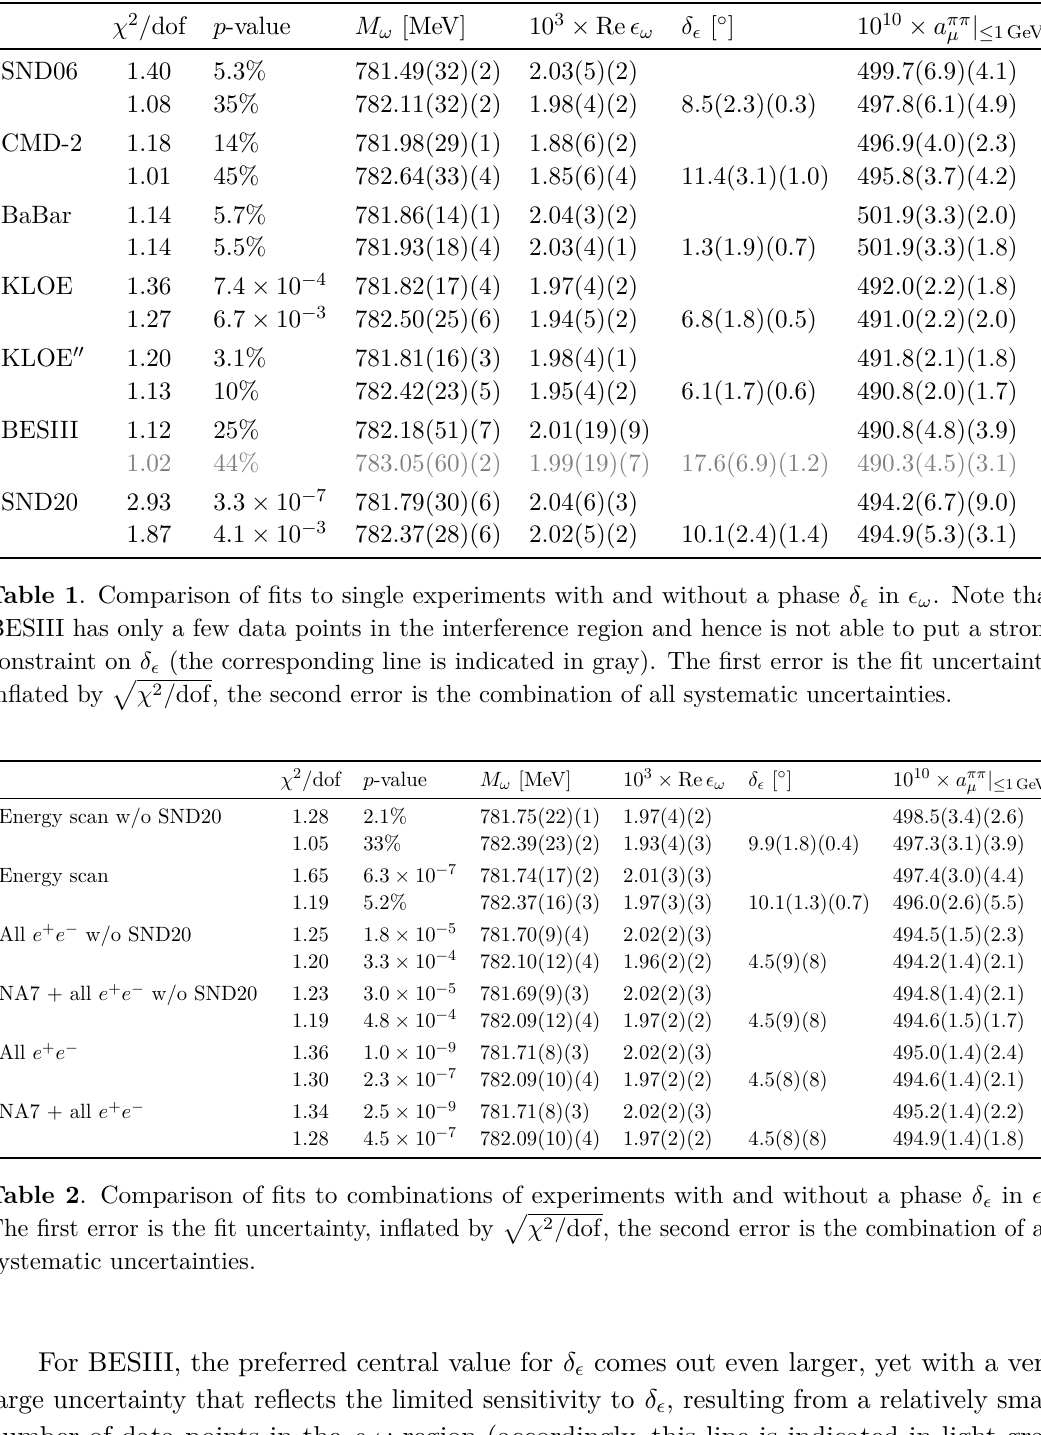
p χ 2 / dof , the second error is the combination of all